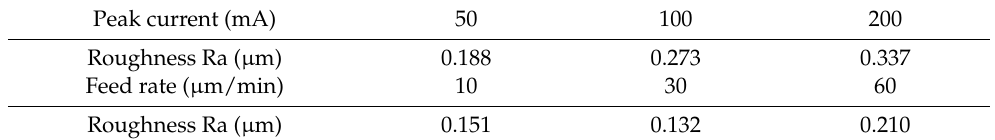
Table 5. Comparison of the ECM milling surface roughness Ra vs. peak current and Ra vs. feed rate.